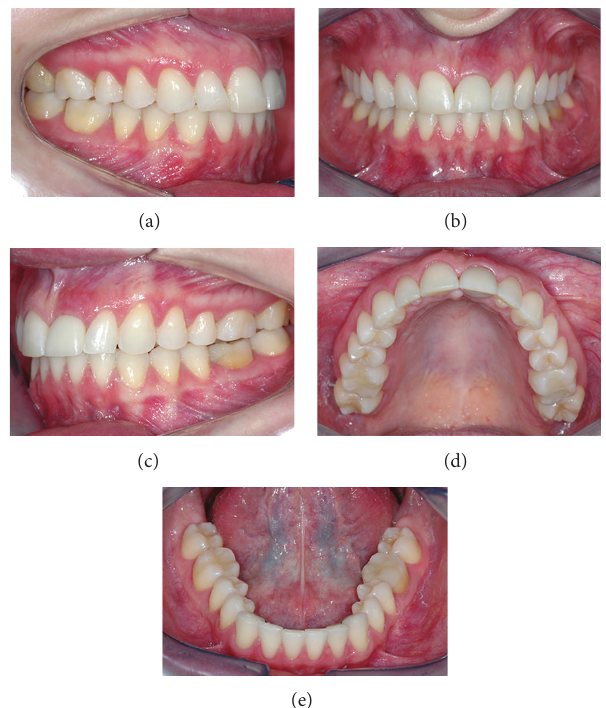
Figure 13: Follow-up clinical views (lateral, central, and occlusal) after 1